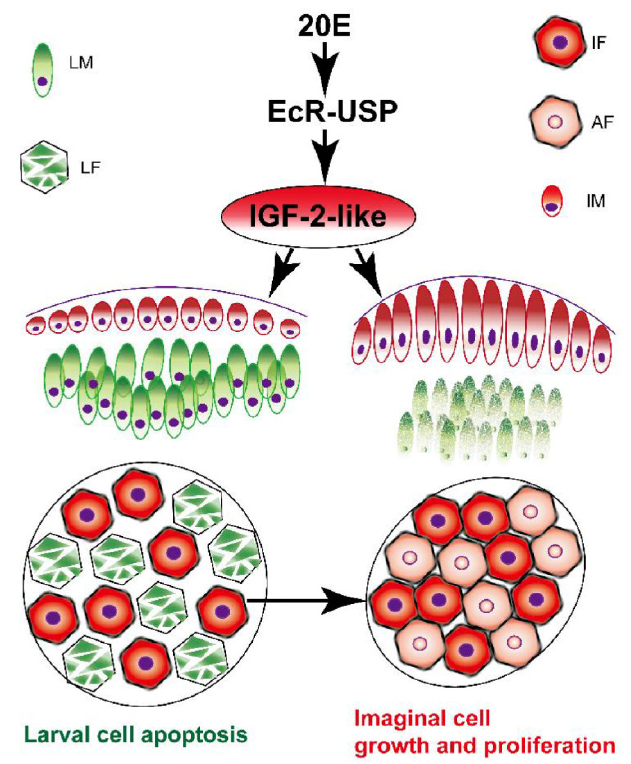
Figure 7. Schematic illustration of the mechanism by which IGF-2-like functions to determine cell proliferative fate. The 20E increases the expression of Igf-2-like via the nuclear receptor EcR. IGF-2-like localizes to the imaginal midgut and fat body to promote imaginal cell growth and proliferation. The larval cells that do not express IGF-2-like die via programmed cell death. LM: larval midgut cells. LF: larval fat body cells. IF: imaginal fat body cells (progenitors of adult fat body cells). AF: adult fat body cells proliferated from the progenitor of adult fat body cells. IM: imaginal midgut. Red indicates IGF-2-like expression. Green indicates CASP3 expression.